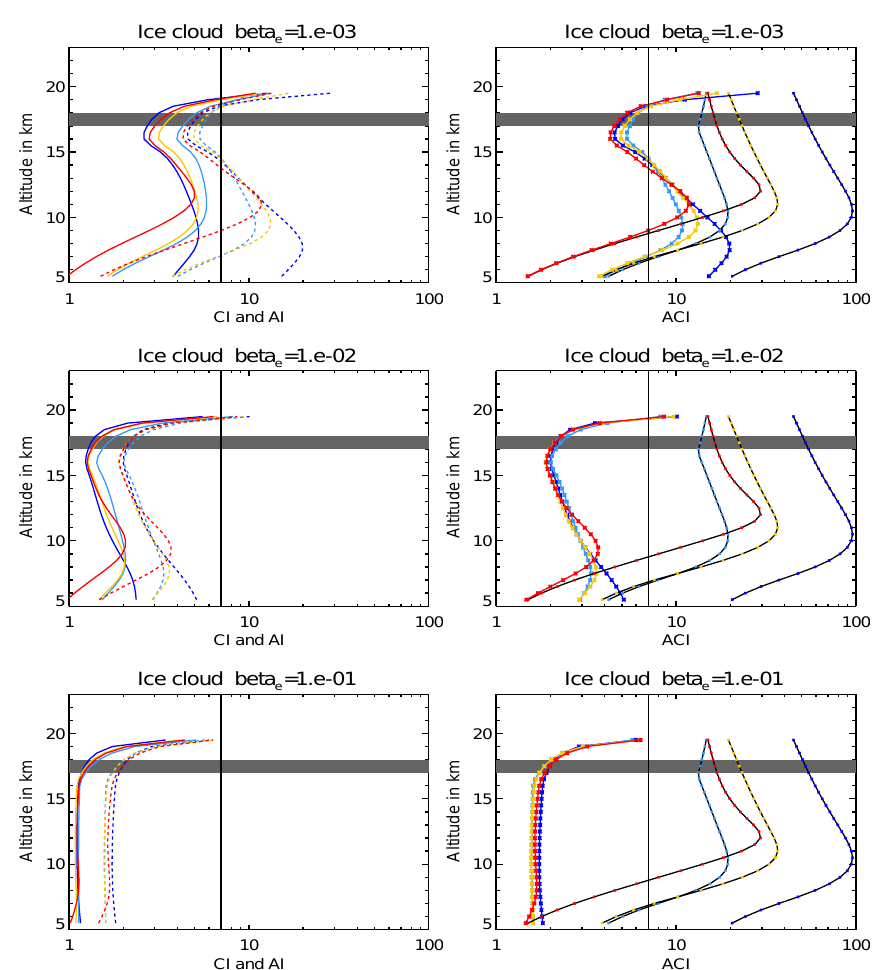
Figure A5. Simulated profiles for a 1km thick ice cloud for three extinctions and the mode radius of 24µm. Left column: CI (solid lines) and AI (dashed lines). Right column ACI for cloud (coloured lines) and clear air (black lines). The grey area indicates the cloud layer. The colours indicate the atmosphere type: blue – polar winter; light blue – polar summer; yellow – midlatitude; red – tropical